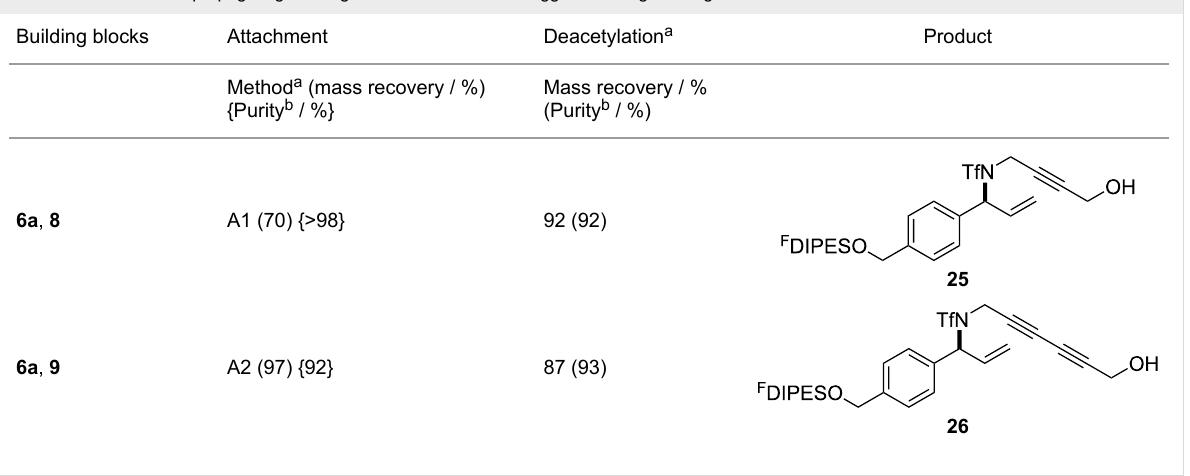
Table 1: Attachment of propagating building blocks to the fluorous-tagged initiating building